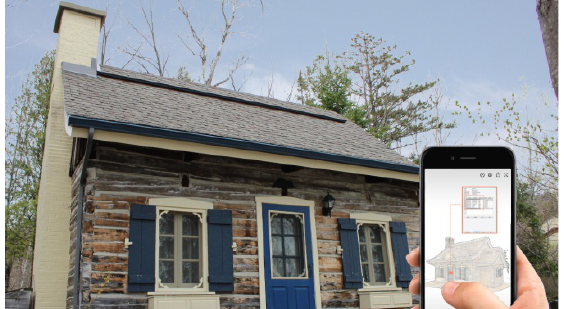
Figure 19. Concept of a mobile app for log